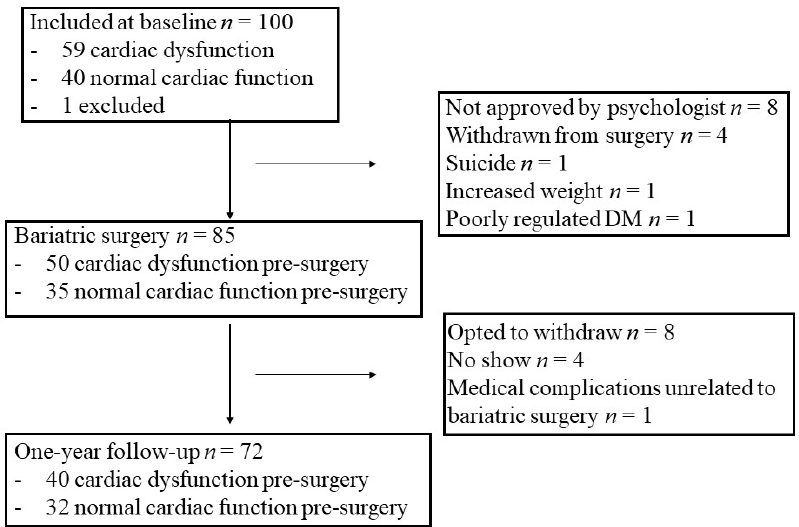
Figure 1. Flow chart of follow-up. DM = diabetes